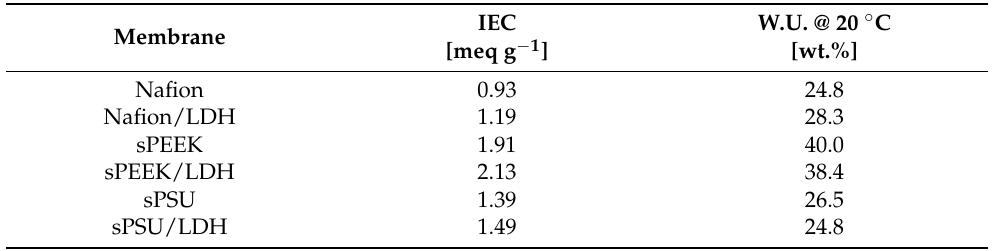
Table 1. Ion Exchange Capacity (IEC) and water uptake (W.U.) values for the various pristine and nanocomposite